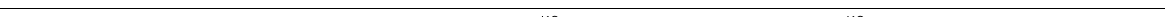
Fig. 3 Growth and energy expenditure phenotypes of adult Dlx1/2 cKO mice. a Postnatal death of Dlx1/2 cKO mice from a total of 14 litters. b , c Dwar fi sm of Dlx1/2 cKO male mice ( n = 3) ( b ) and quali fi cation of their linear body length, body weight, IGF1 expression in the liver (by qRT-PCR) and serum glucose levels ( c ), relative to their littermate males controls ( n = 5). The ruler unit in b is in cm. d MRI analyses of fat and lean mass revealed an increased fat deposition in Dlx1/2 cKO male mice ( n = 5) relative to their control male mice ( n = 5). e Food intake measurement revealed no signi fi cant difference between control ( n = 6) and Dlx1/2 cKO male mice ( n = 4) throughout the diurnal cycles. f VO 2 /VCO 2 measurements uncovered a signi fi cant decrease in energy expenditure in Dlx1/2 cKO male mice ( n = 3) relative to their controls ( n = 3). g Circadian home cage activity was continuously measured using a home cage sensor system and mLog software (BioBServe, Germany). h Basal body temperature measurement revealed a signi fi cant reduction in female Dlx1/2 cKO mice ( n = 4) relative to their littermate female controls ( n = 6), as well as a trend for reduced body temperature with male Dlx1/2 cKO mice ( n = 6) relative to their littermate male controls ( n = 6), which did not reach statistical signi fi cance ( p , 0.06). The p -values by two-way ANOVA test were 0.002 for VO 2 measurement but not signi fi cant (NS) for VCO 2 measurement, as indicated ( f ). Student ’ s t -test results are as indicated: ∗ p < 0.05, ∗∗ p < 0.01, ∗∗∗ p < 0.001, and ∗∗∗∗ p < 0.0001 ( c , d , f , h ). The home cage activity and food intake during the light and dark periods were analyzed separately using repeated-measures ANOVA with genotype as the between-subjects factor ( e , g ). Bars represent mean, error bars represent the